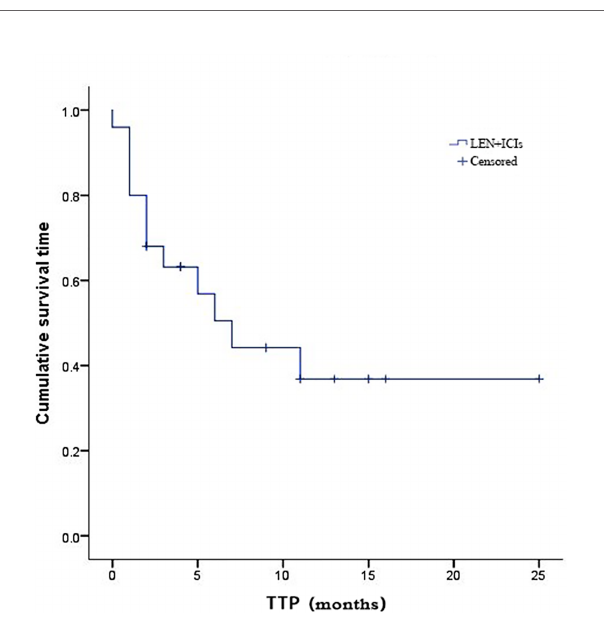
FIGURE 3 | Kaplan-Meier estimates of progression-free survival for 27 eligible patients with advanced hepatocellular carcinoma who were treated with lenvatinib plus immune checkpoint